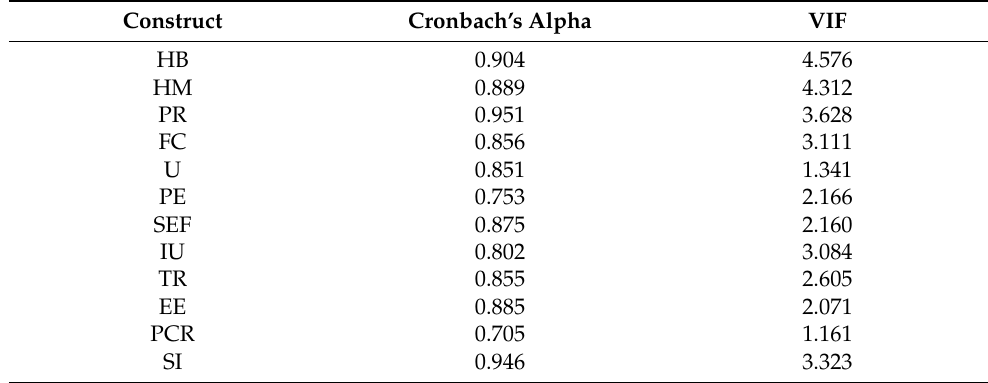
Table 2. Validity and Multicollinearity.